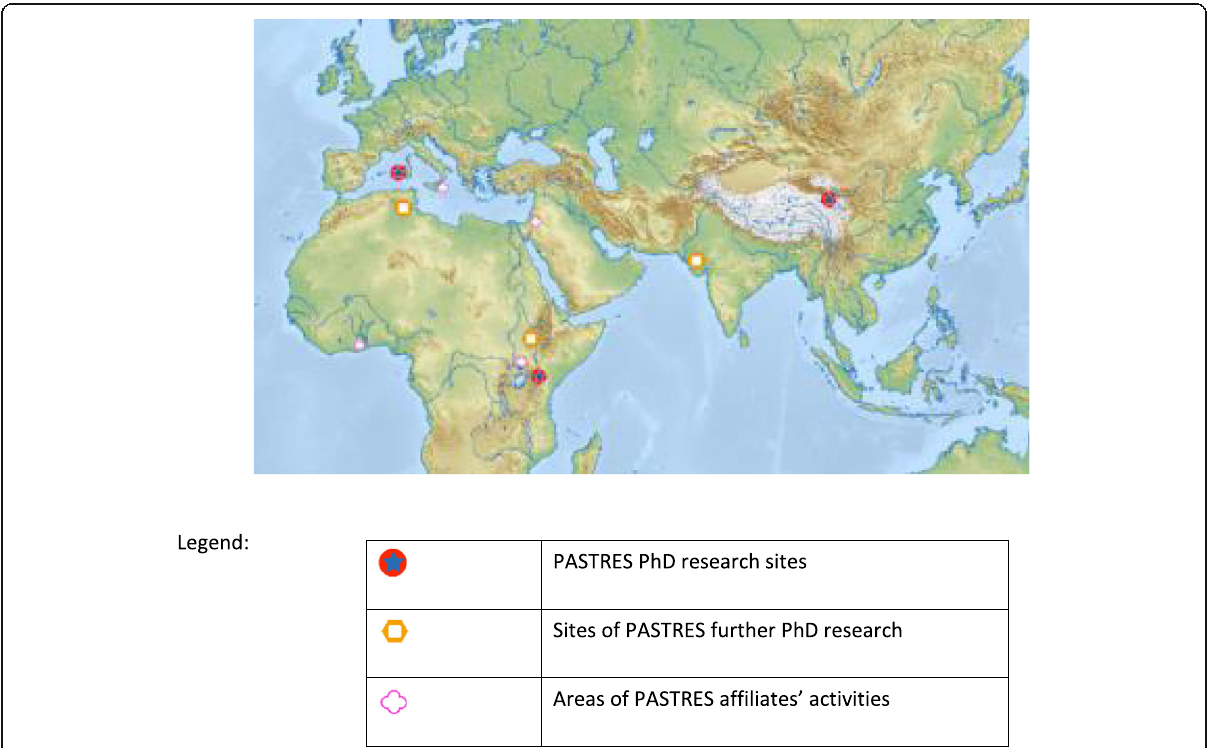
Fig. 1 PASTRES areas of research and